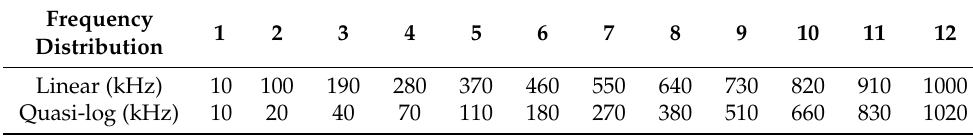
Table 1. The excitation frequencies in this work ranged from 10 kHz to about 1 MHz.